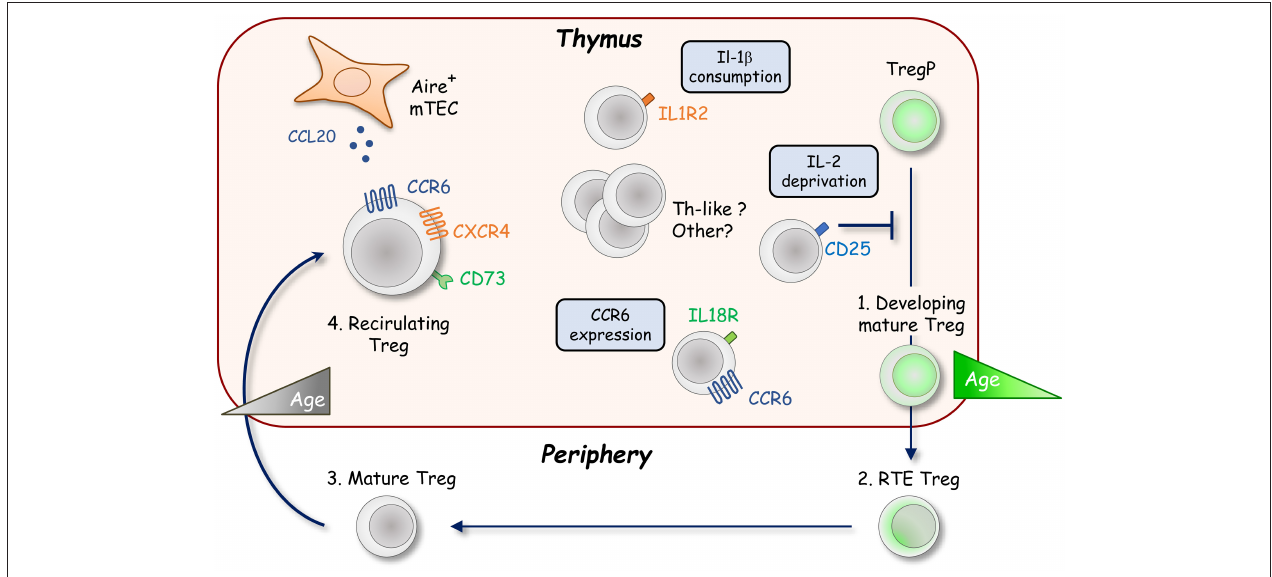
FIGURE 2 | Recirculation of peripheral Foxp3 + Treg into the thymus. The thymic Foxp3 + Treg population is not only composed of developing Rag2- GFP + Treg (green cell) but also contains a large fraction of recirculating mature Rag2- GFP − Treg from the periphery showing an activated phenotype (gray cells). The recirculation of peripheral Treg likely depends on CCR6 and CXCR4 chemokine receptors. These cells mainly localize into the thymic medulla in response to the production of the CCR6 ligand, CCL20, by Aire + mTEC. Once in the thymus, recirculating CCR6 + CD73 + Treg inhibit the development of de novo CD25 + Foxp3 + Treg in an age dependent manner by IL-2 deprivation. Distinct subsets of recirculating Treg were recently described such as IL-1R2 + Treg that maintain Treg development by quenching IL-1 β under inflammatory conditions. An IL-18R + subset, endowed with a higher ability to recirculate into the thymus than their IL-18R − Treg counterparts, was also described. In this subset, IL-18 signaling likely promotes the thymic entry of peripheral Treg by upregulating CCR6